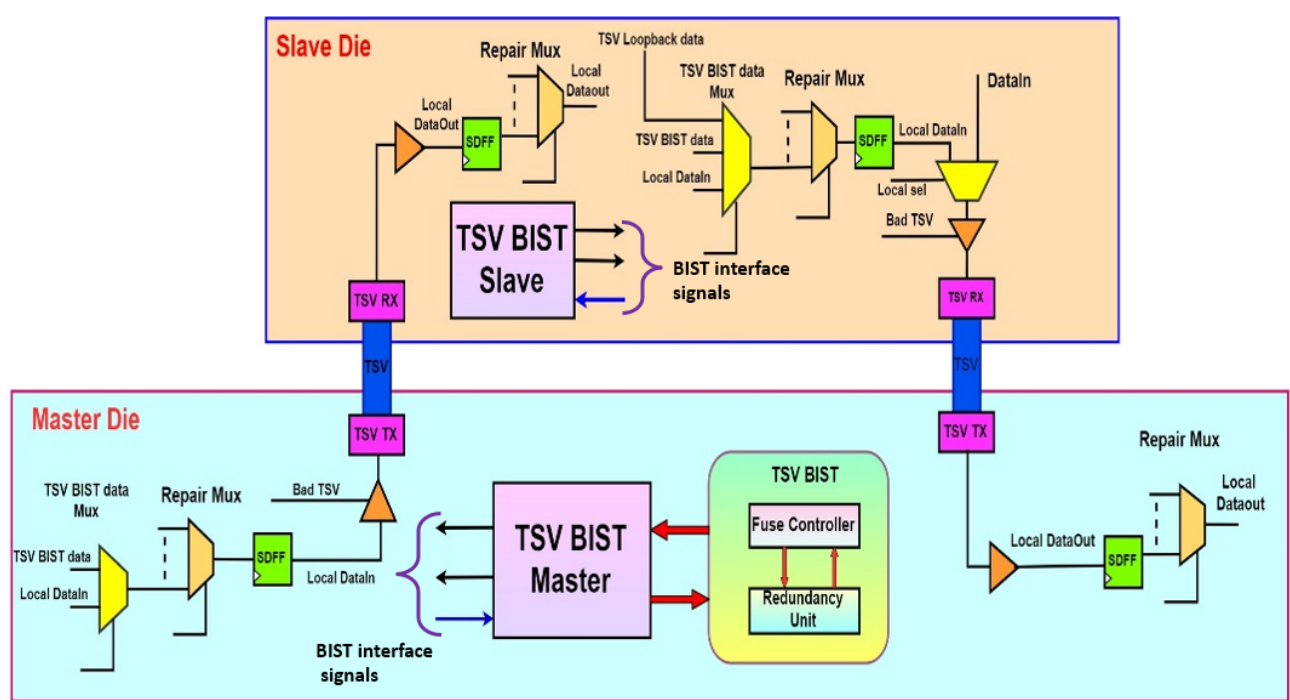
Figure 3. Proposed TSV BIST repair architecture for 3D-stacked ICs (Reprinted with permission from ref. [21]. Copyright 2022 Springer Nature)